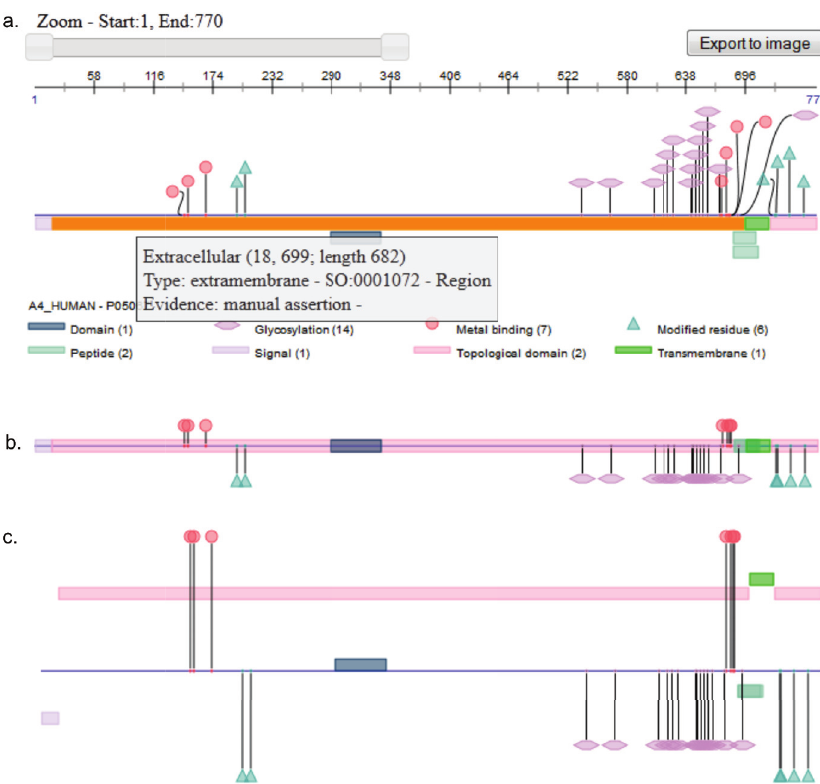
Figure 3. This visualization corresponds to the UniProt protein “Amyloid beta A4 protein” in the non-overlapping style; interactions such as shape dragging, tooltip, and selection as well as user controls such as zooming and image exporting are illustrated in this figure; b . shows the centralized view, while c . shows the by-rows view.